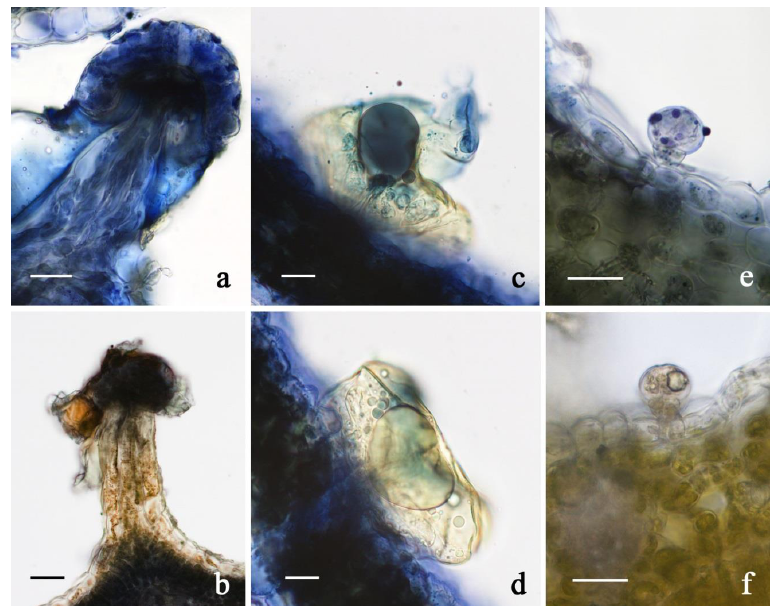
Figure 10. LM micrographs showing the results of the histochemical investigation on the glandular trichomes in the investigated C. sativa varieties. ( a , b ) Capitate-stalked trichome: Nadi reagent ( a ), Ferric Tricloride ( b ); ( c , d ) capitate-sessile trichome: Nadi reagent; ( e , f ) bulbous trichome: Nadi rea- gent ( e ), Ferric Tricloride ( f ). Scale bars = 20